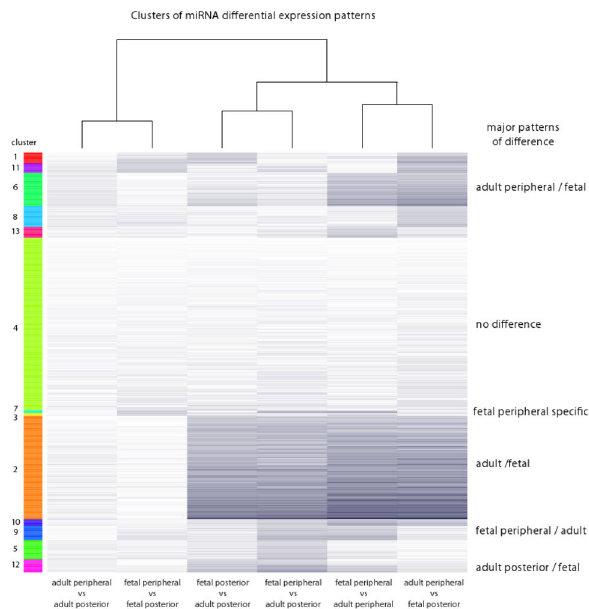
Figure 3. Patterns of micro-RNA expression differences examined by cluster analysis. The false discovery rate controlled p- values were k-means clustered to identify major patterns driving the differences in micro-RNA expression between different samples. The k-means cluster centers were themselves hierarchically clustered to identify the relationships between the different